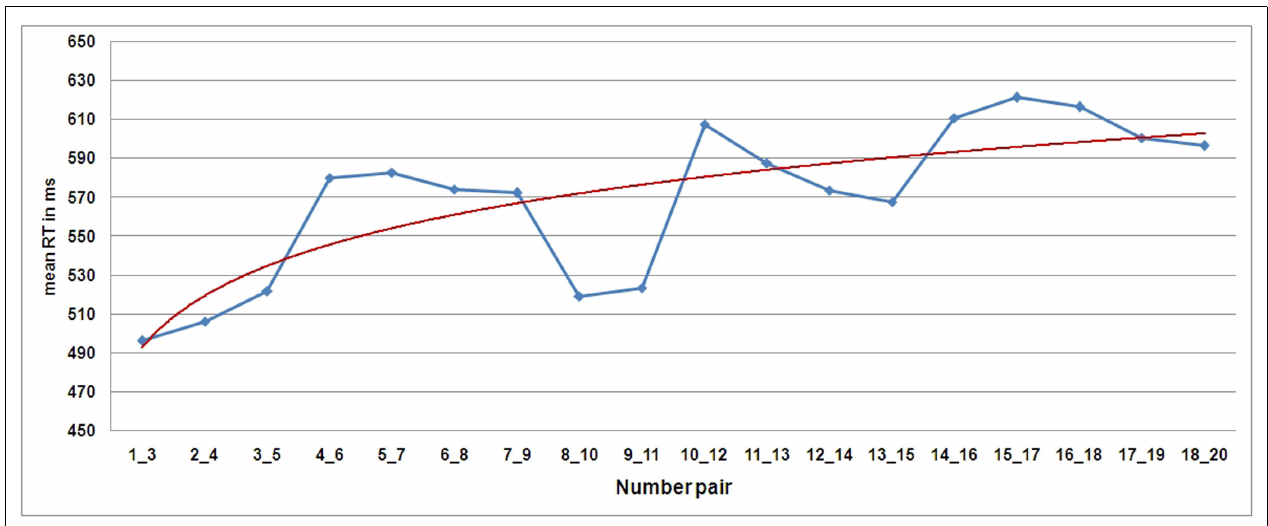
FIGURE 3 | Mean reaction times per number pair (blue line) and logarithmic fitting (red line) of KSL participants ( n = 23). For a description of the fitting procedure see Domahs et al. (2010).